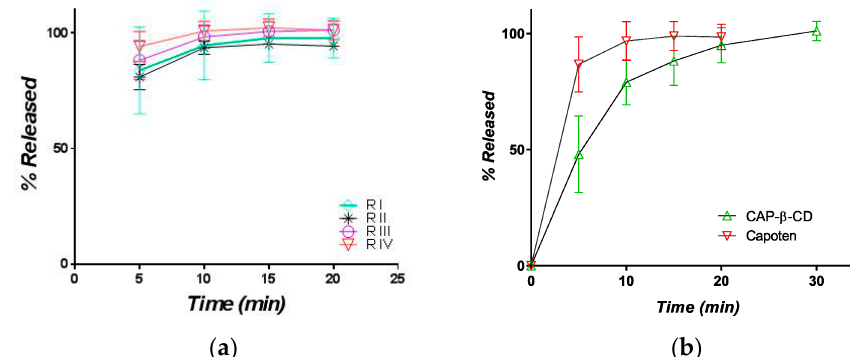
Figure 10. Mean release profile of CAP in HCl 0.01N from ( a ) 4 different CAPOTEN ®® batches and ( b ) a comparative profile between CAPOTEN ®® and the experimental orally disintegrating tablets containing CAP- β -CD.